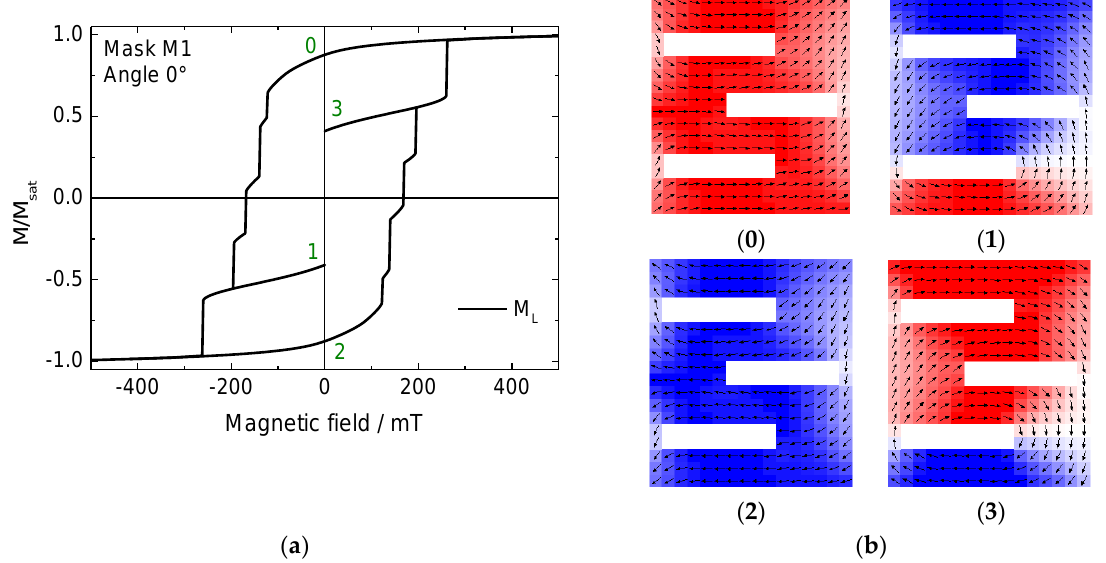
Figure 2. ( a ) Hysteresis loop and ( b ) snapshots of stable intermediate states #0–3, simulated for mask M1 under a field angle of 0°.